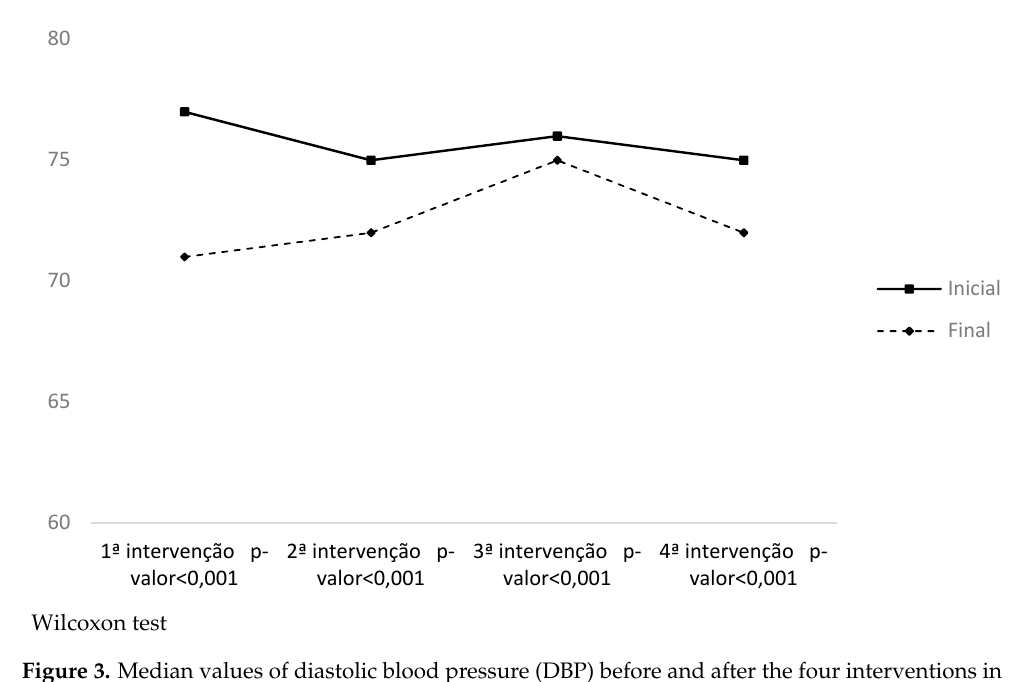
Figure 2. Median values of systolic blood pressure (SBP) before and after the four interventions in the IG (Raja yoga meditation).